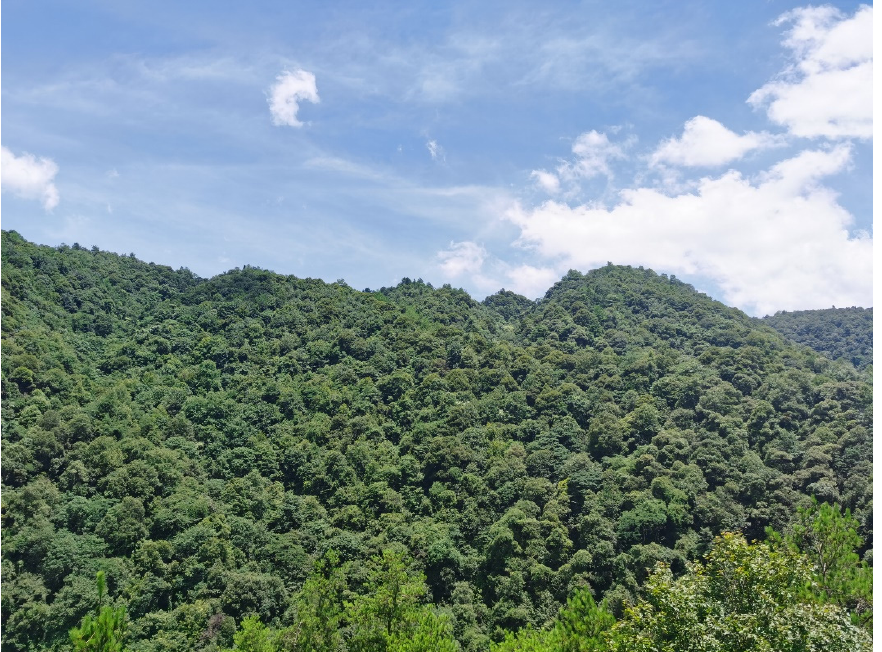
Figure 2. Typical evergreen broad-leaved forest in study area. The photo was taken in Nanshan National Park in Hunan province of China (provided by Hunan Nanshan National Park Admin- istration).